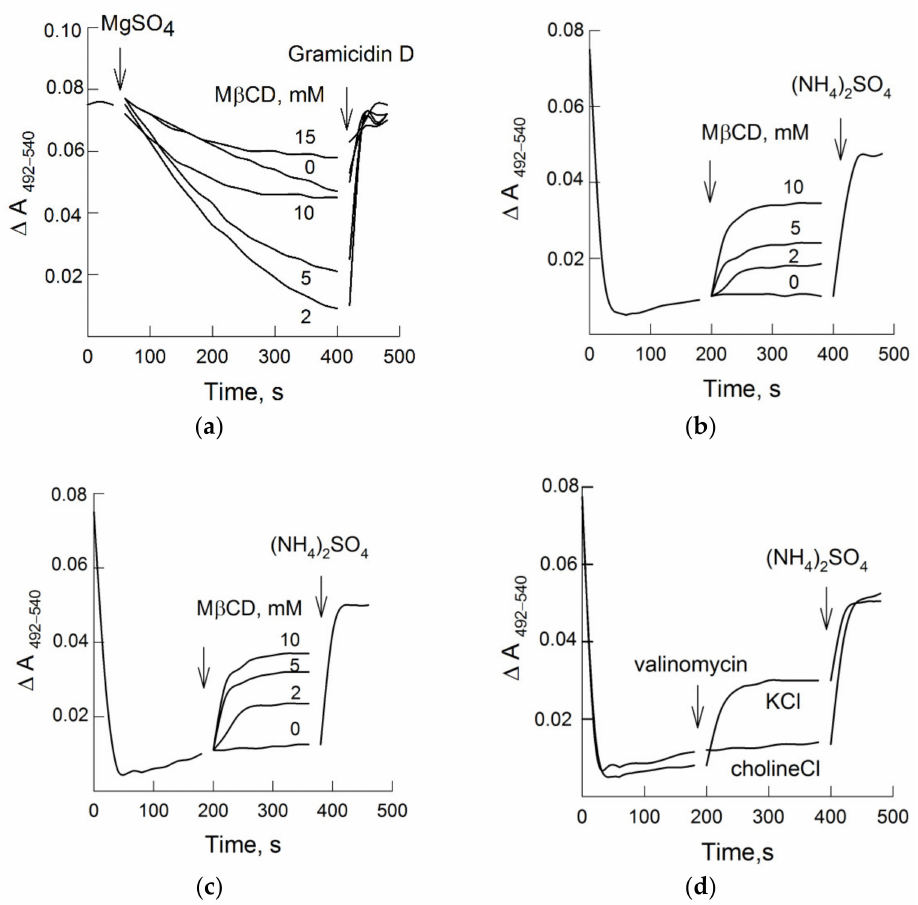
Figure 2. Effects of different M β CD concentrations on ATP-dependent ( a ) and passive ( b – d ) H + - transport. Plasma membranes were added into a medium with 50 mM KCl and M β CD ( a ). In ( b – d ), vesicles were preliminary loaded with (NH 4 ) 2 SO 4 and then placed into measuring medium supplemented with 50 mM KCl ( b ) or 50 mM cholineCl ( c ). After a decrease in the absorbance of acridine orange, M β CD ( b , c ) or 50 nM valinomycin ( d ) was added. ATP-dependent ∆ pH was dissipated by 2 µ M Gramicidin D; the artificial pH gradient was disrupted by the addition of 10 mM (NH 4 ) 2 SO 4 . Representative kinetics curves are